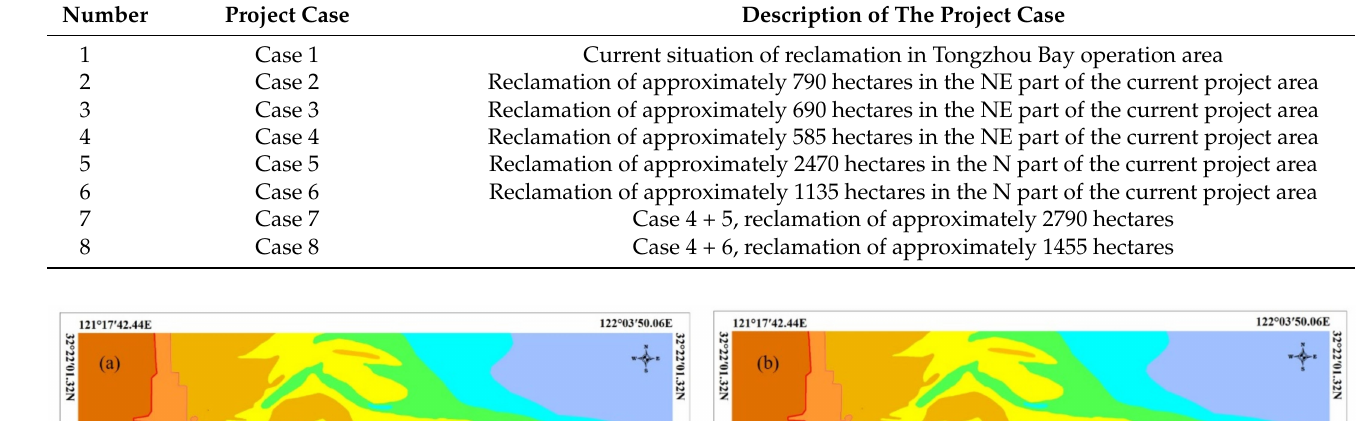
Figure 4. Reclamation project case of study area. Table 2. Reclamation project cases.